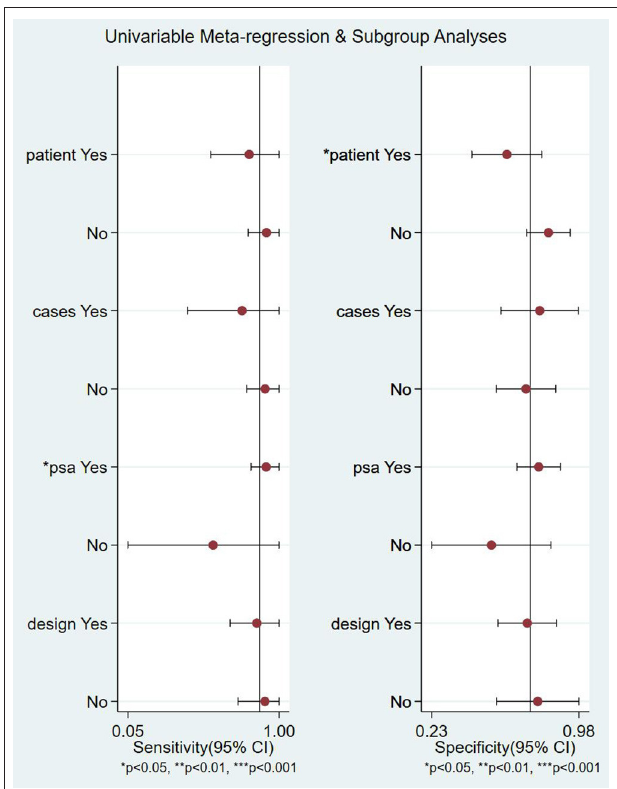
FIGURE 5 | Meta-regression and subgroup analyses of studies. CI, confidence interval; PSA, prostate-specific antigen.